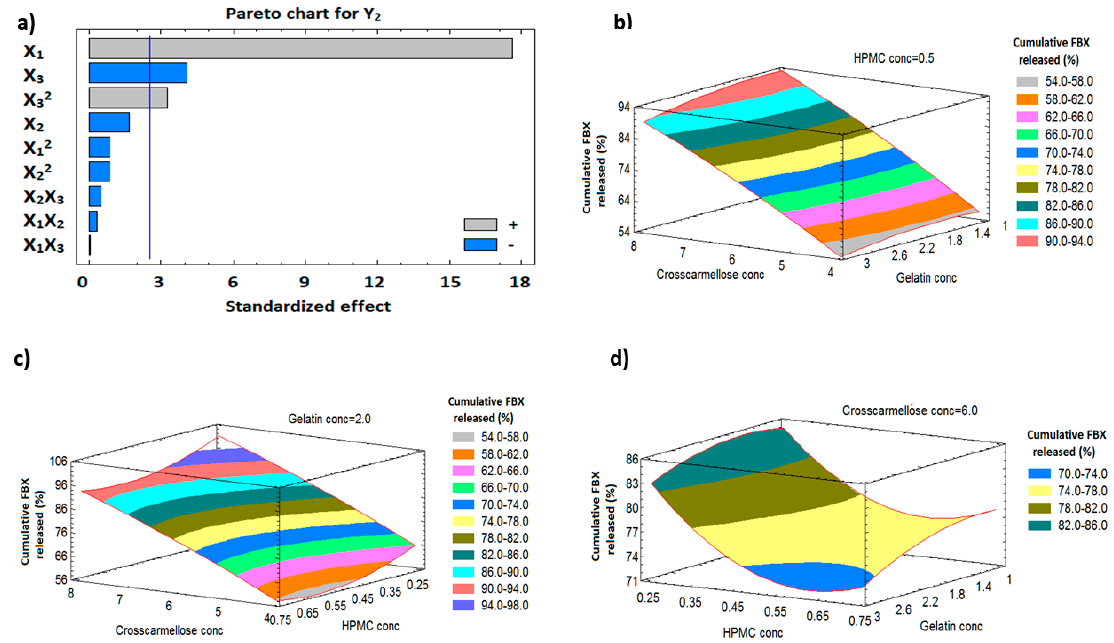
Figure 6. Pareto chart ( a ) and response surface plots ( b – d ) showing the effect of the independent variables on cumulative FBX release (Y 2 variables on cumulative FBX release (Y 2 ).